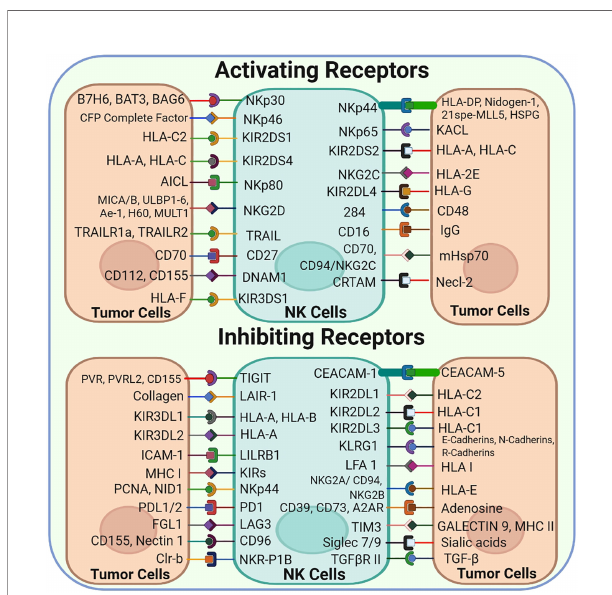
FIGURE 2 | NK-Cell Surface Receptors and their corresponding ligands: NK cells express a vast array of both Activating and inhibitory cell surface receptors that interact with their corresponding ligands found on the tumor cell